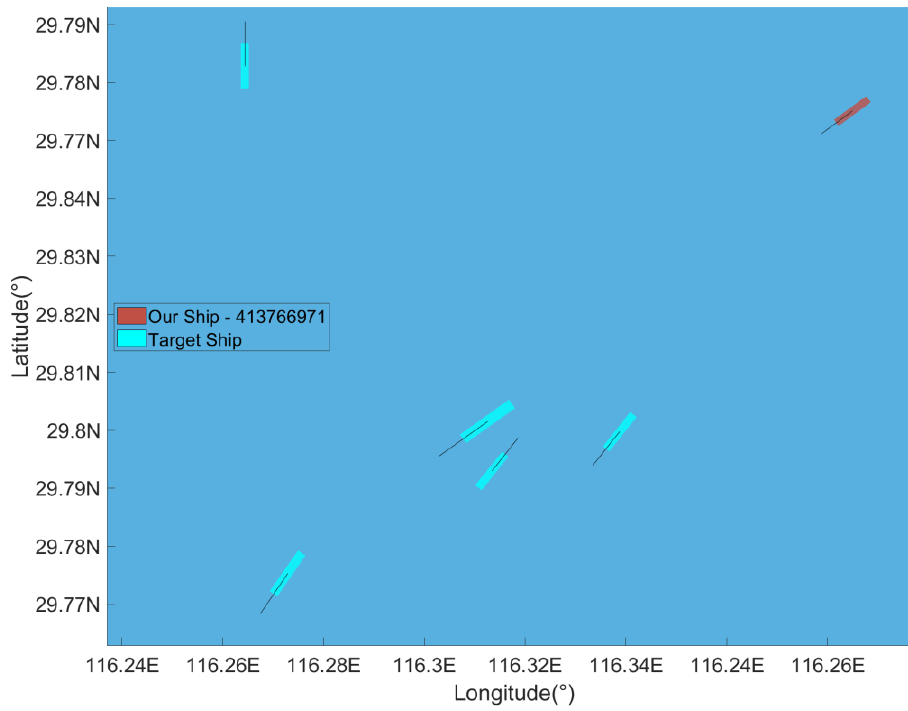
Figure 17. Relative position of each ship in Case 4. Table 9. Risk assessment results of Case